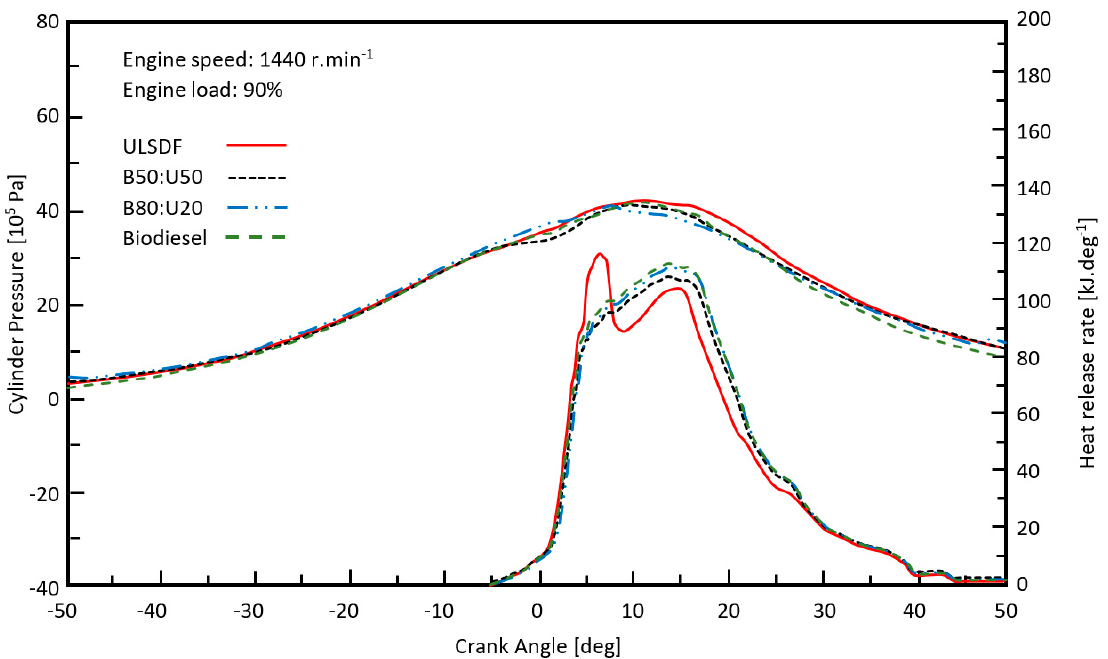
Figure 7. Tested fuels’ influence on the heat release rate and cylinder pressure at 1200 rpm and 30% load .